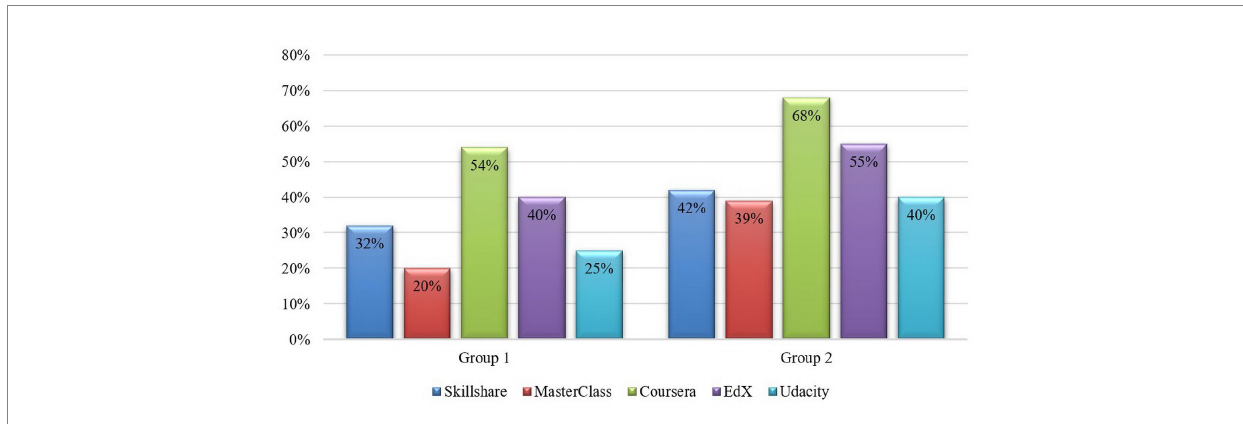
FIGURE 12 Answers to the question: what online educational platforms do you use for training? (Post-training survey). Source: compiled by the